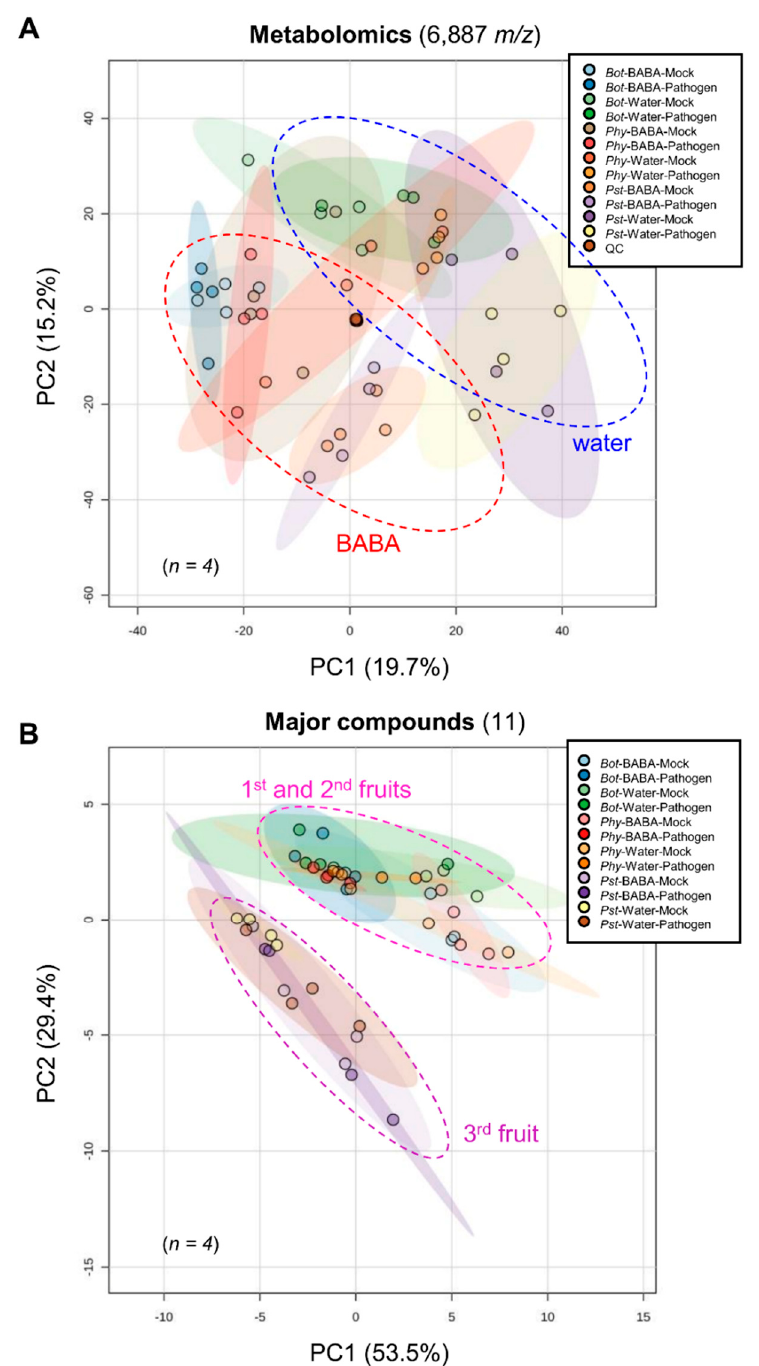
Figure 3. Global metabolomic changes after BABA treatment and after pathogen inoculation. Principle component analysis (PCA) score plots ( n = 4) of 6887 LCMS-based metabolomics features ( A ) and 11 major compounds analysed by targeted biochemical phenotyping ( B ). Maximal variance explained by each PC is given in brackets.